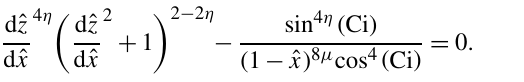
Figure 11. Time-invariant profiles (shown in non-dimensionalized form) obtained by direct integration of the model (Sect. 4.3) for two (cid:9) and three choices of Ci ∈ { 0 . 1 ◦ , 1 ◦ , 4 ◦ } ; for each value η , the flow exponent µ is chosen such that µ/η = 1 , 3 choices of η ∈ (cid:8) 1 2 2 channel incision number Ci sets the overall steepness since it effectively defines the gradient at the exit x = 0. Given a value of Ci, the profiles for η = 3 and η = 1 are approximately the same until x ≥ 0 . 95 L c 2 2